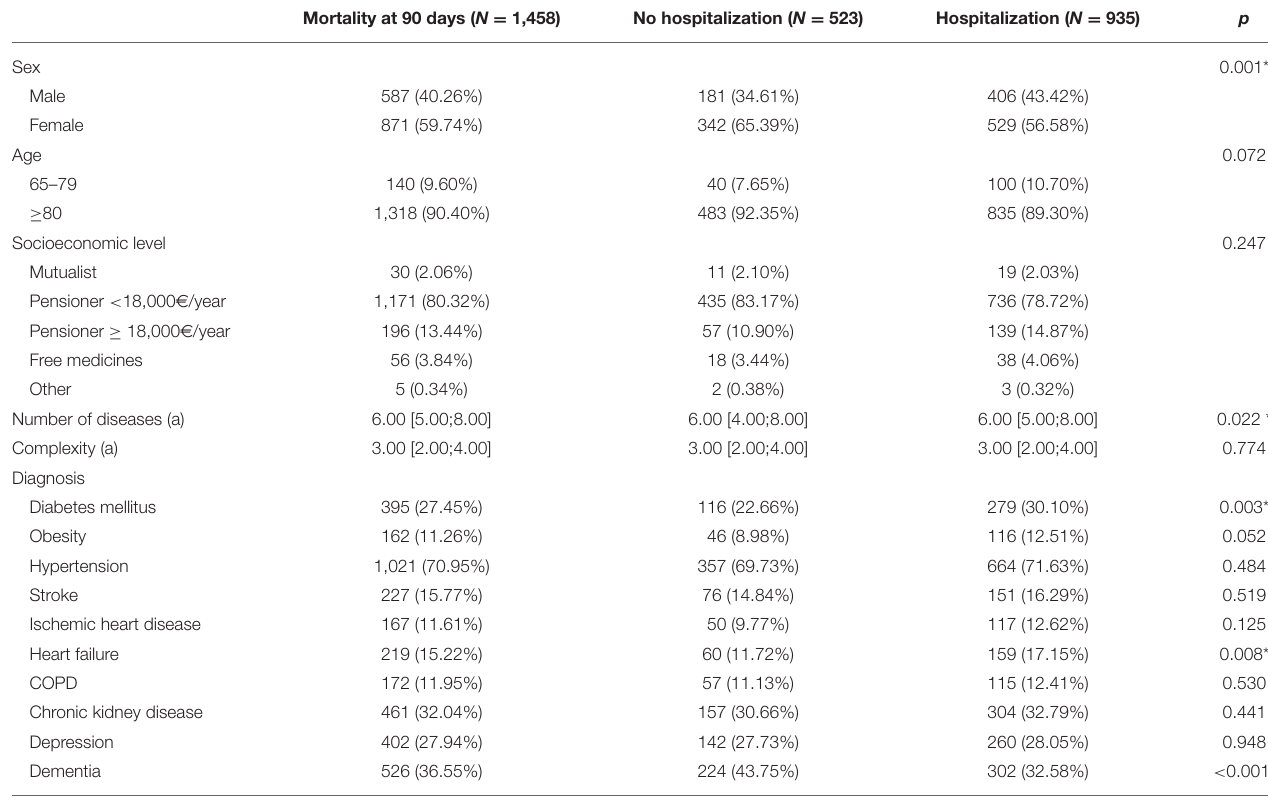
TABLE 3 | Hospitalization in COVID-19 confirmed institutionalized patients over 64 years of age who died. Mortality at 90 days ( N = 1,458) No hospitalization ( N =